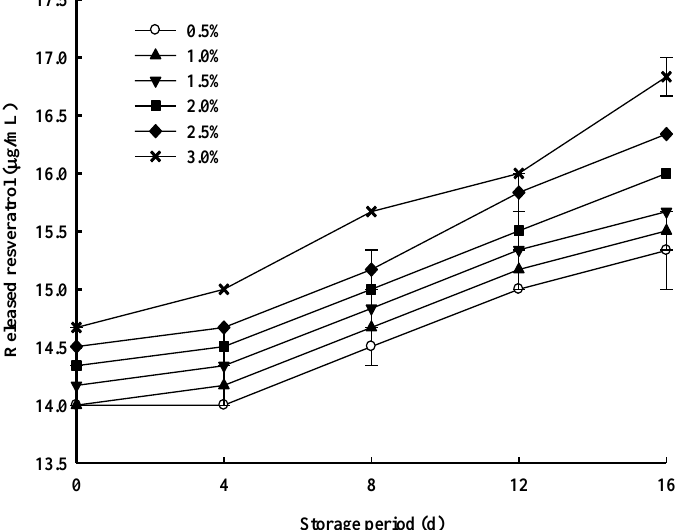
Figure 3. Measurement of resveratrol for released powdered peanut sprout microcapsule-supplemented milk stored at 4  C for 16